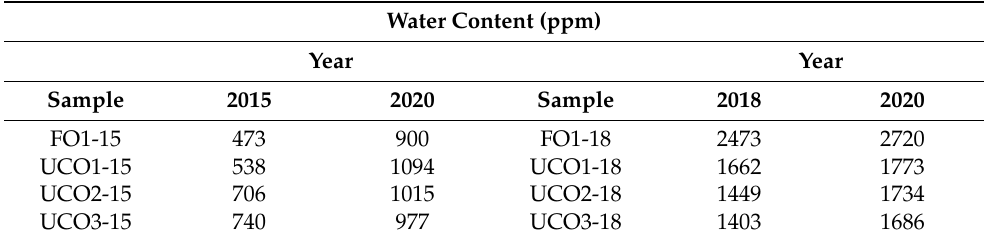
Table 2. Water content of bio-oils measured in the years 2015, 2018, and